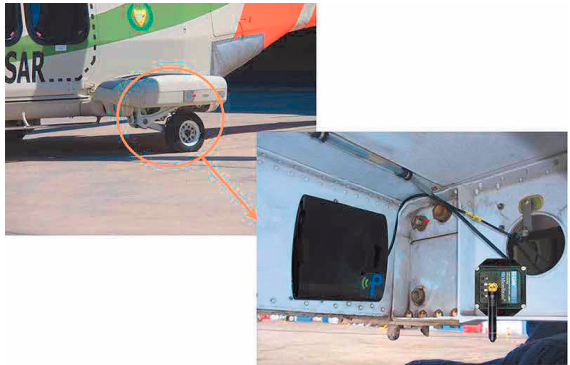
Figure 41. RF collector and wireless sensor in the landing gear unit of an AW139 helicopter [216].